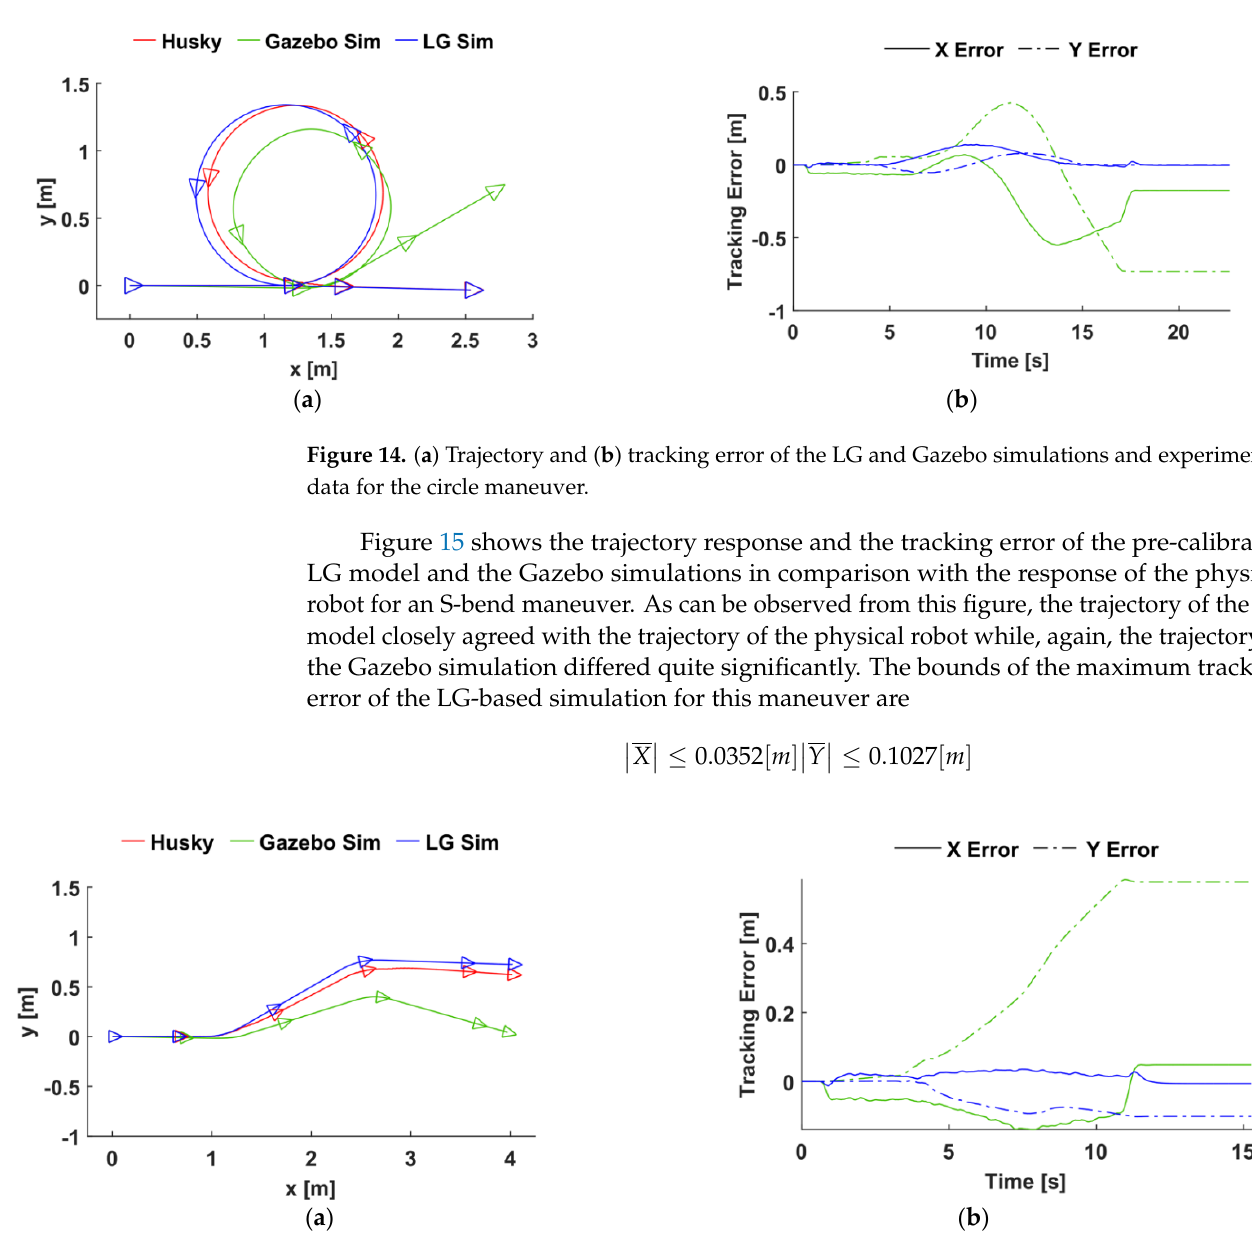
Figure 15. ( a ) Trajectory and ( b ) tracking error results of the LG and Gazebo simulations compared with experimental data for the S-bend maneuver.